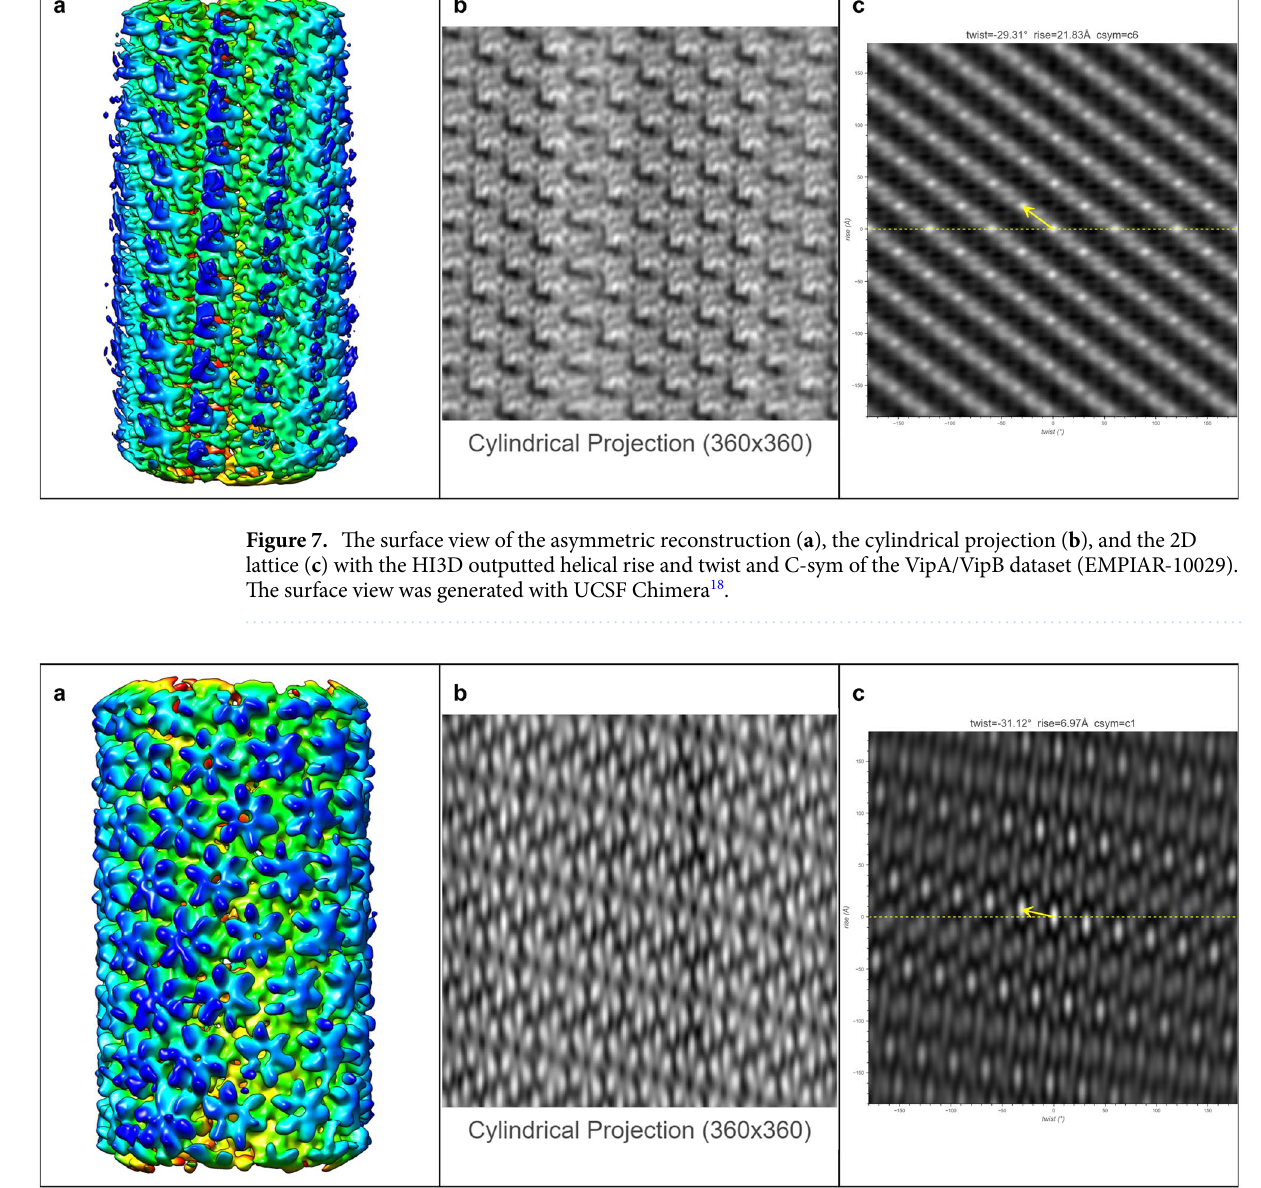
Figure 8. The surface view of the asymmetric reconstruction ( a ), the cylindrical projection ( b ), and the 2D lattice ( c ) with the HI3D outputted helical rise and twist and C-sym of the major class of the HIV capsid protein dataset (provided by Dr. Peijun Zhang). The surface view was generated with UCSF Chimera 18